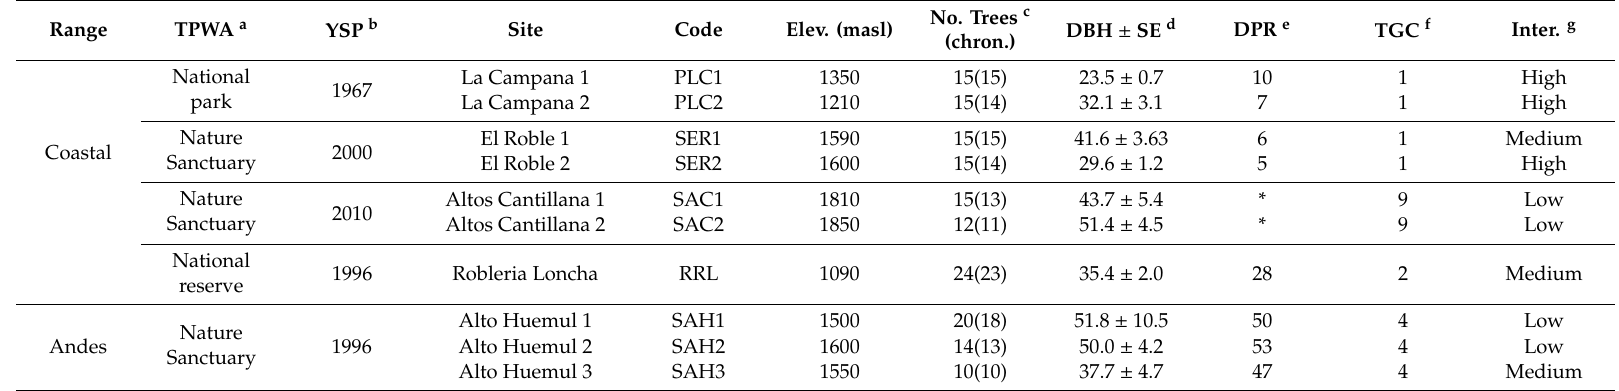
Table 1. Description of N. macrocarpa sites and wood